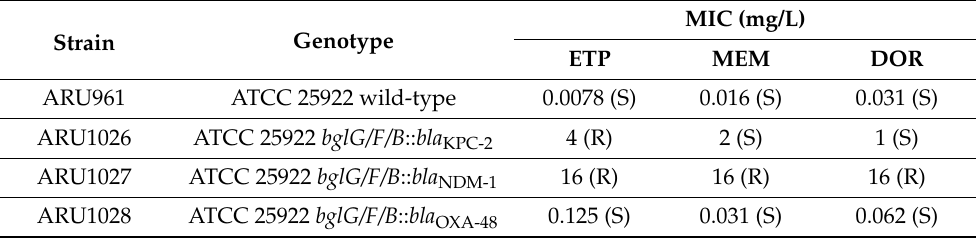
Table 3. MIC values for ertapenem, meropenem, and doripenem for E. coli ATCC 25922 and con- structed carbapenemase-producing strains. MICs are classified according to EUCAST clinical break- points, version